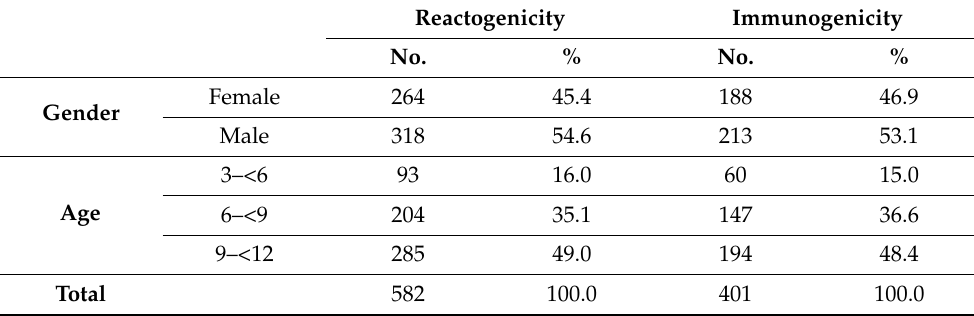
Table 1. The age and sex of participants.